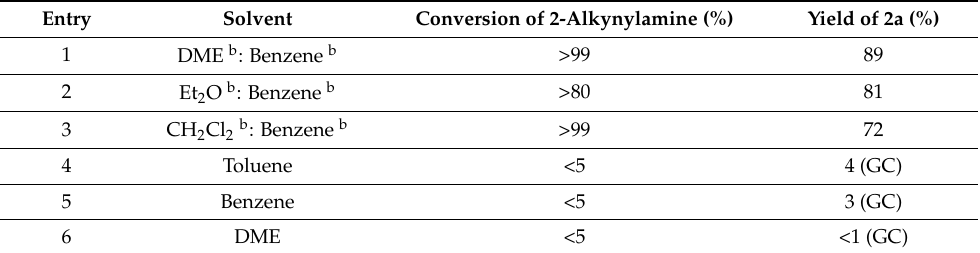
Table 1. Effect of the solvent nature on the reduction of 2-alkynylamines with the NbCl 5 –Mg reagent system a